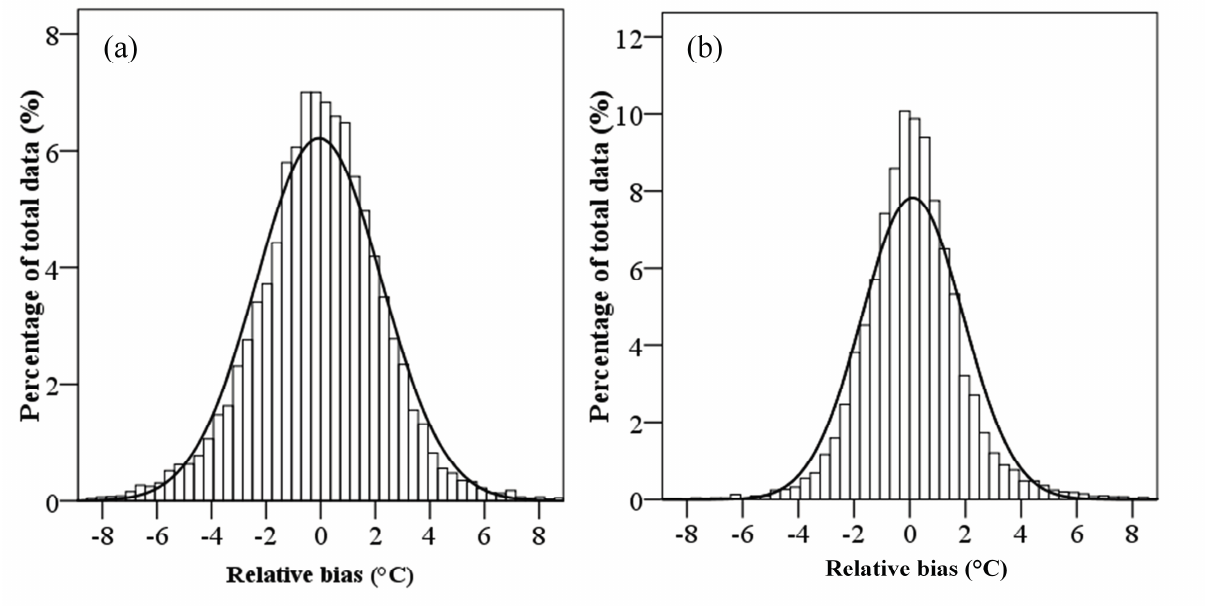
Figure 2. Relative bias distribution considering all Tmax ( a ) and Tmin ( b ) estimations with the selected models in the study area for all the three land-cover types. (The black curves are the normal distribution